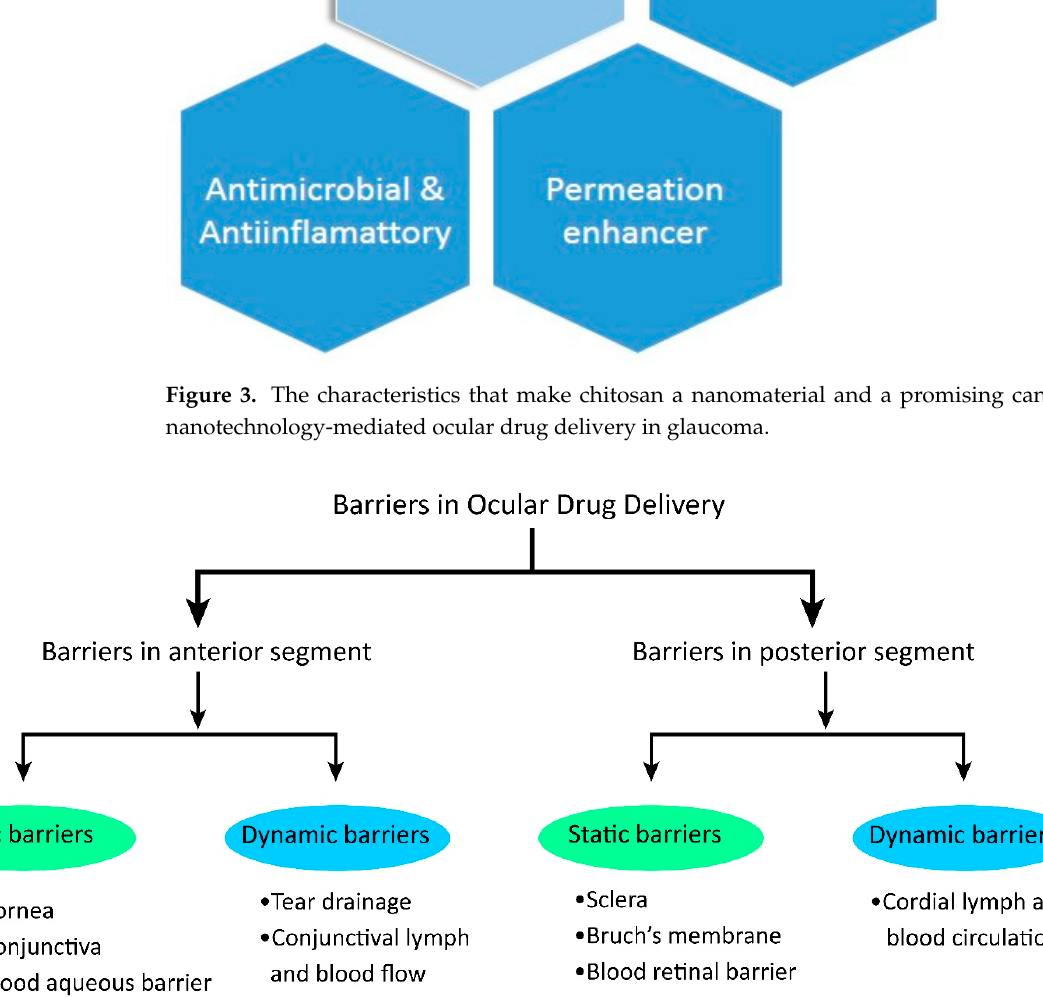
Figure 4. Different barriers in ocular drug delivery for glaucoma pose challenges in ocular bioavailability.